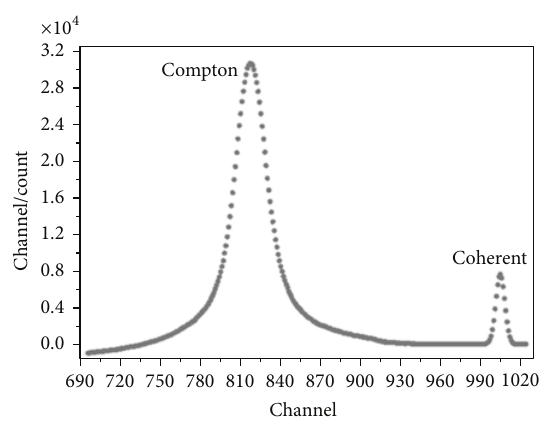
Figure 4: A typical Compton and coherent scattering spectrum from pure Vanadium